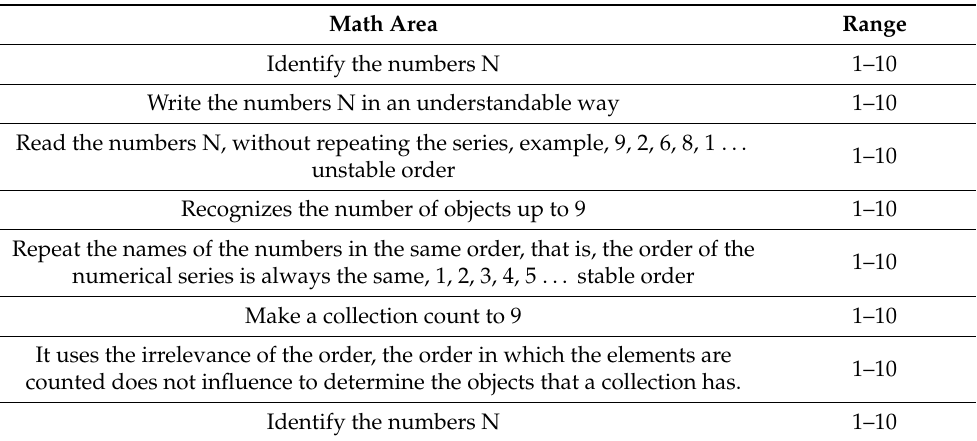
Table 1. Example of the evaluation guide on teaching numbers. Math